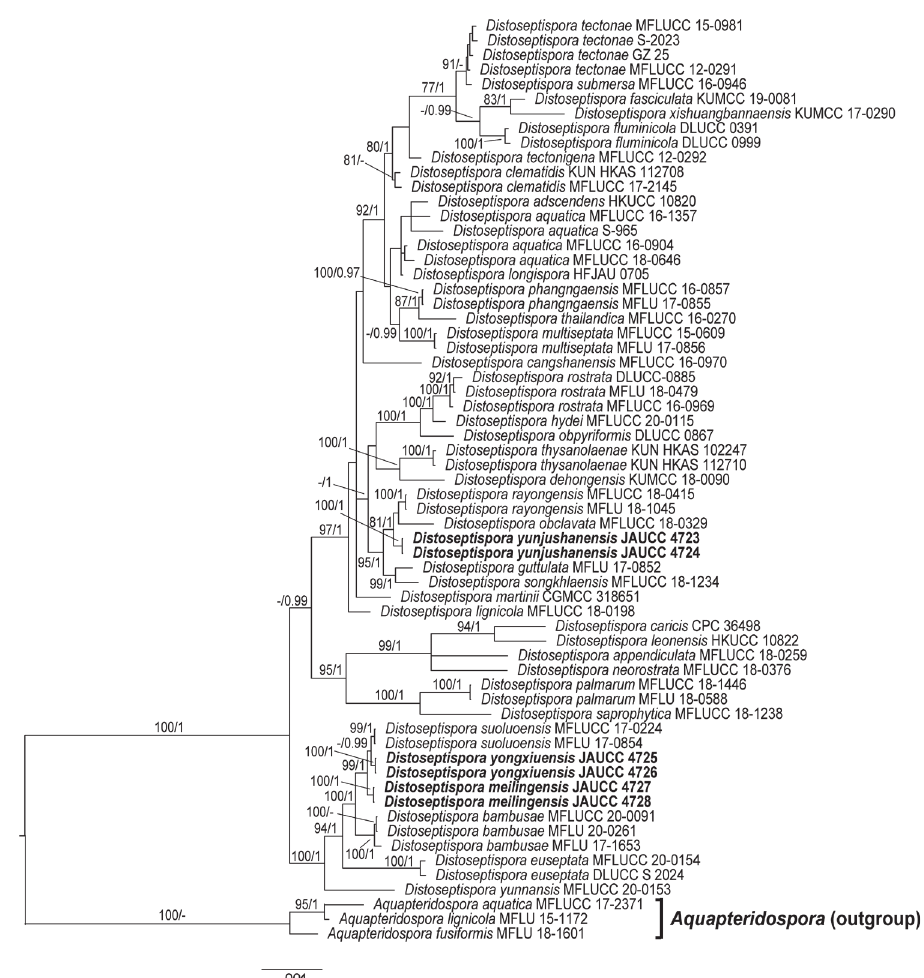
Figure 1. Phylogenetic tree of Distoseptispora , inferred from the combined regions (ITS-LSU-SSU- Tef 1 α ) using Bayesian Inference (BI) analysis. The Aquapteridospora clade was used as the outgroup. The lineages with new species were shown in bold. PP ≥ 0.95 and BS ≥ 75% were indicated around the branches. The new sequences generated in this study are given in